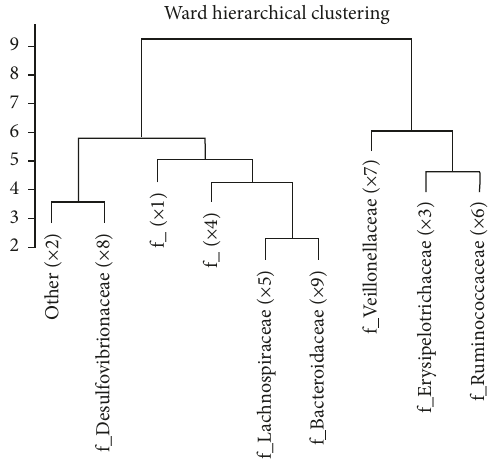
Figure 1: Female dataset at family taxonomic level. Dendogram obtained using Ward’s method for obtaining the principal balances. The table shows the expression of the principal balances and their percentage of